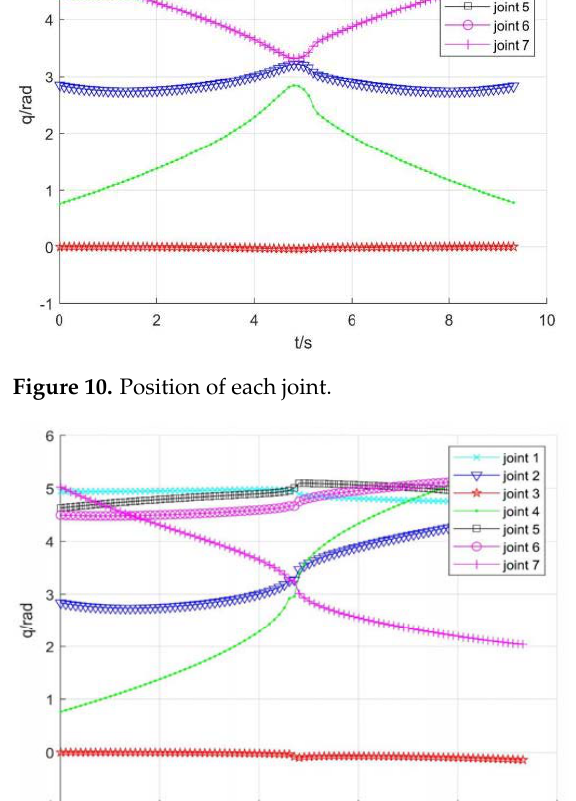
Figure 11. Velocity of each joint.